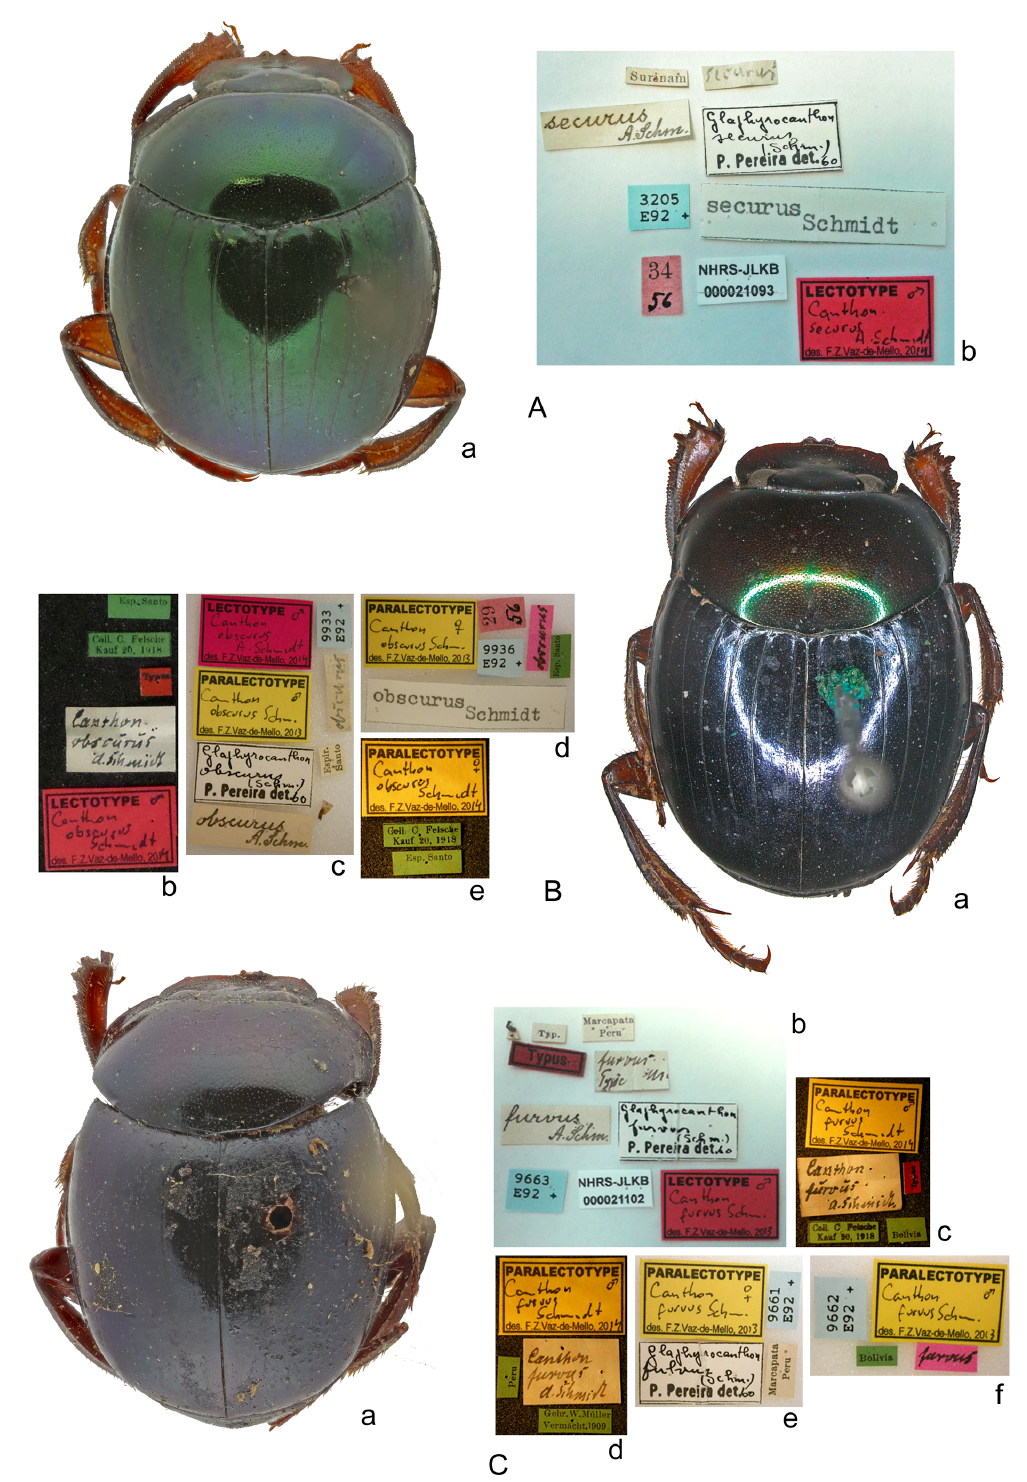
Fig. 40. Type material of three species of Sylvicanthon described by Schmidt (1920). A . S. secures (Schmidt, 1920) comb. nov. a . Lectotype. b . Lectotype’s labels. B . S. obscurus (Schmidt, 1920). a . Lectotype. b . Lectotype’s labels. c . Paralectotype 1. d . Paralectotype 3. e . Paralectotype 9. C . S. furvus (Schmidt, 1920). a . Lectotype. b . Lectotype’s labels. c . Paralectotype 4. d . Paralectotype